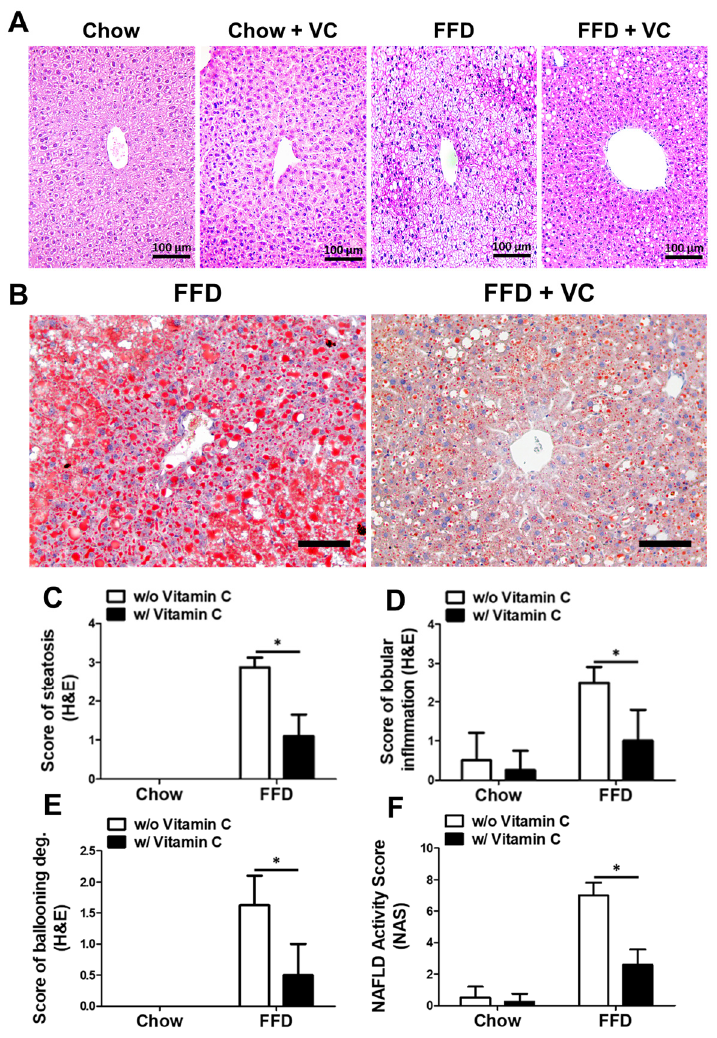
Figure 3. Mega-dose vitamin C treatment attenuated NAFLD progression microscopically. ( A ) Representative images of H&E staining of liver sections; ( B ) Representative images of Oil-Red O stain- ing of frozen liver sections in FFD-fed mice groups; ( C ) Histopathological scores of steatosis; ( D ) lobular inflammation; ( E ) ballooning degeneration; and ( F ) NAFLD activity scores (NAS). Data are expressed as means ± SD per group ( C – F ). n = 5 mice in each group ( C – F ). * p < 0.05. Scale bars = 100 μ m ( A ) and 200 μ m ( B ). Original magnification, 200× ( A ) and 100× ( B ). 3.4. Mega-Dose Vitamin C Treatment Attenuated Liver Injuries in the FFD-Fed Mice In the biochemical analysis, the FFD-fed group exhibited notably increased serum liver enzyme levels such as ALT, ALP, and AST compared to the chow-diet-fed groups. However, the FFD + VC group exhibited notably decreased serum ALT, ALP, and AST levels despite the fast-food diet feeding (Figure 4A–C). These data demonstrate that vita- min C attenuated FFD-mediated liver injuries. However, serum levels of nutrients includ- ing glucose and FFA were similar in all FFD-fed mice groups despite the serum liver en- zyme differences between the FFD and FFD + VC groups (Figure 4D,E). We are confident that nutrient absorption was not affected by vitamin C supplementation in the FFD-fed groups. Vitamin C treatment showed an improvement in the serum liver enzyme levels as well as attenuated NASH lesions in FFD-fed mice.